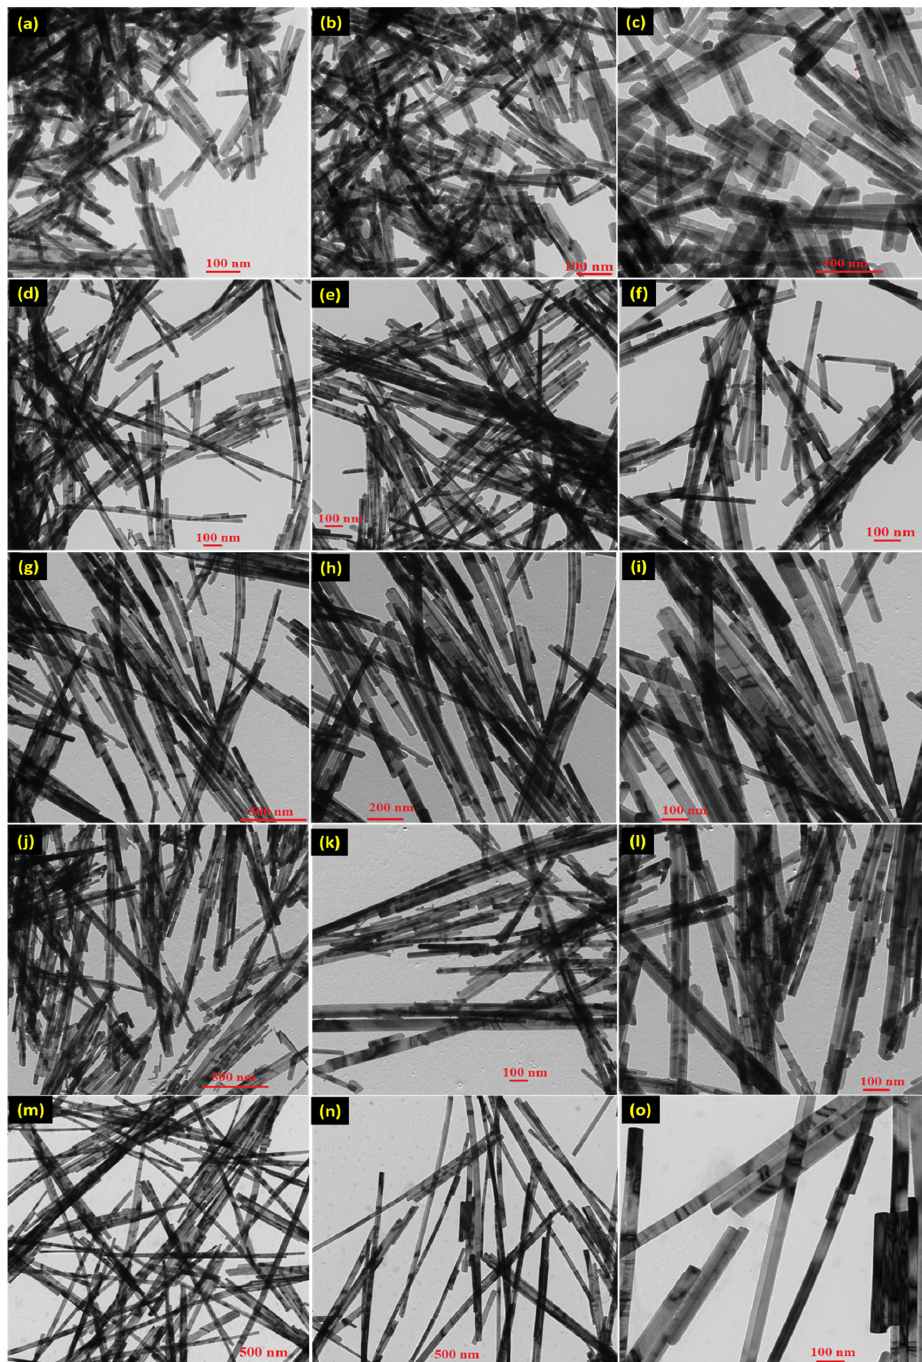
Figure 1. FE-SEM images of as prepared CdS nanorods at a reaction times of 6 h ( a,b ), 12 h ( c,d ), 18 h ( e,f ), 24 h ( g,h ), and 48 h ( i,j ).